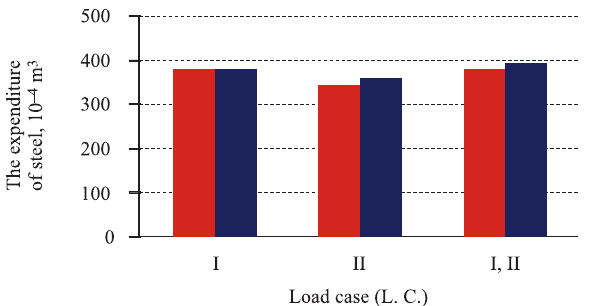
Fig. 6. The expenditure of steel, when h = 2.911 m